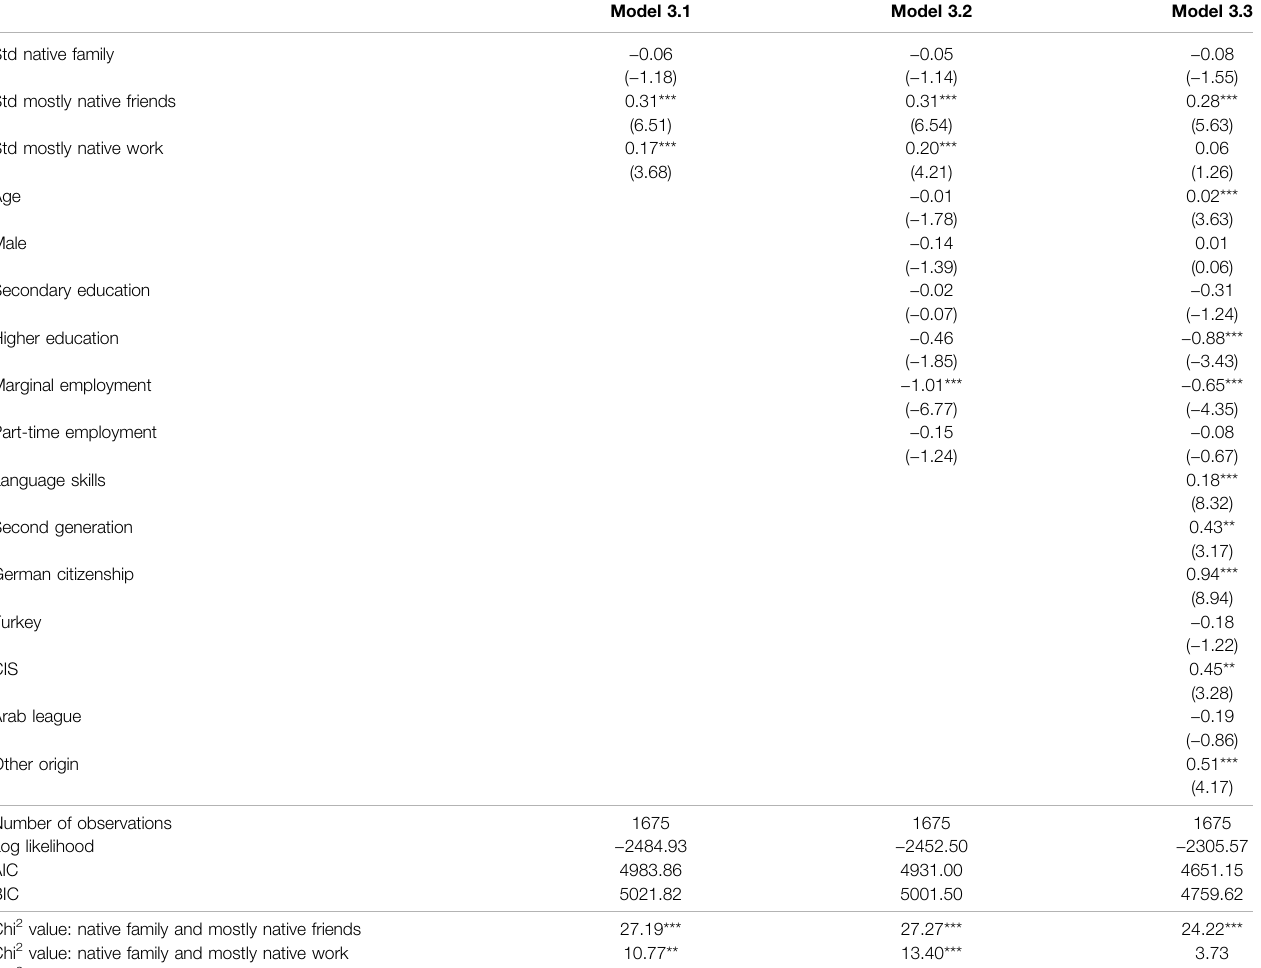
TABLE A2 | Cross-sectional ordered logit models with sample from lagged